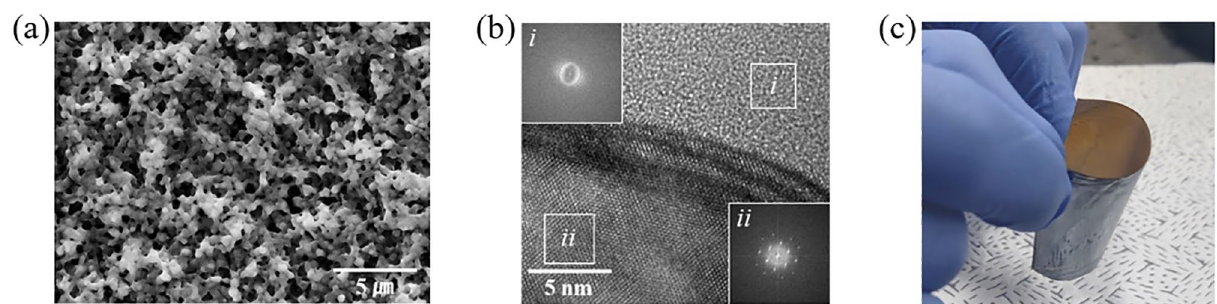
Figure 4. ( a ) SEM image of the porous SiO 2 surface on a bendable SiO 2 /Si film, ( b ) HRTEM image of the interface of the SiO 2 /Si film (insets: FFT SAED patterns of the SiO 2 part ( i ) and Si part ( ii )), and ( c ) the image of the freestanding bendable porous SiO 2 /Si